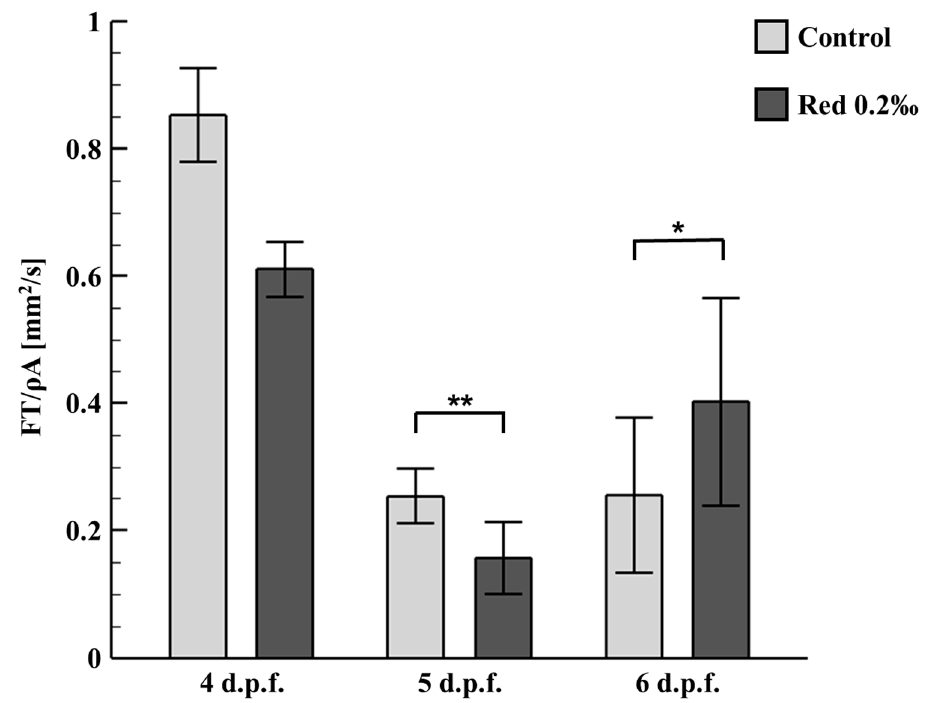
Figure 4. Effects of the cochineal red additive on tail-beating force of zebrafish larvae (4, 5, and 6 d.p.f.). Zebrafish larvae (5 and 6 d.p.f.) showed a transit change in the tail-beating force hydrodynamically with effective test samples in each experimental group. Significant differences between the control and the exposure groups are indicated by asterisks, (* p < 0.05) and (** p < 0.01) as compared with the control for 4, 5 d.p.f. (N = 10), and 6 d.p.f. (N =